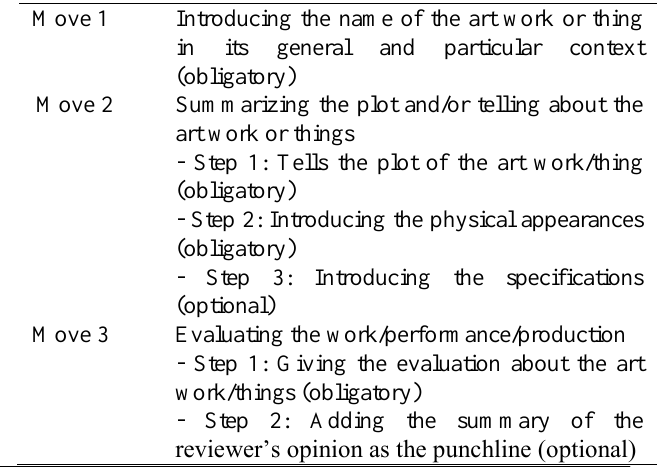
TABLE 1 | Move Analysis of Review Text Modified from Swales (2004) and Guinto